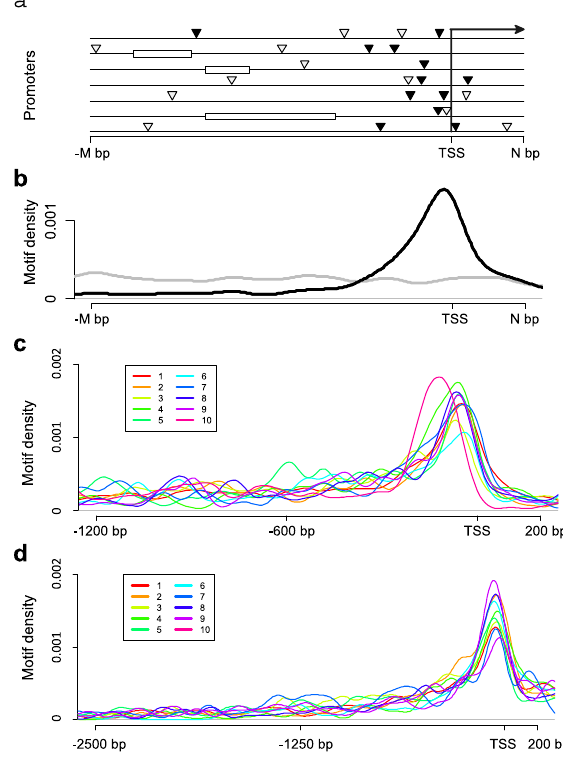
Figure 2. Motif target identified through motif position bias towards TSS. ( a ) A diagram showing a group of promoters. Within the promoters, a random/non-functional motif (grey triangle) distributes randomly along the promoters, while a functional motif (solid black triangle) distributes towards the transcription start site (TSS). The white bars represent transposon or repetitive sequence in the promoters, which are excluded from motif analysis. The arrow indicates the direction of transcription. ( b ) A representative distribution of a random/ non-functional motif (grey line) and a functional motif (black line) with bias distribution along promoters. ( c ) Distribution of the NF-Y (CCAAT) motif within gene promoters from the modules regulated by this motif. Data from the first 10 modules shown in Supplementary Dataset 3 are indicated by different colors, as specified by the color key on the top left. ( d ) Distribution of the Sp1 motif within the gene promoters for modules regulated by the Sp1 motif. Data from first 10 modules shown in Supplementary Dataset 5 are indicated by different colors, as specified by the color key on the top